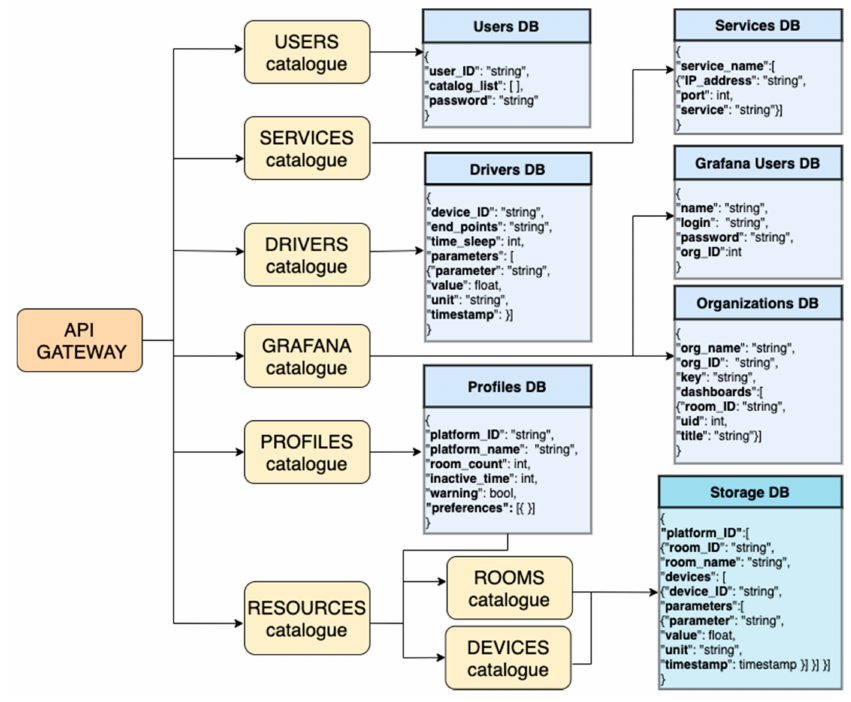
Figure 4. Database structure for